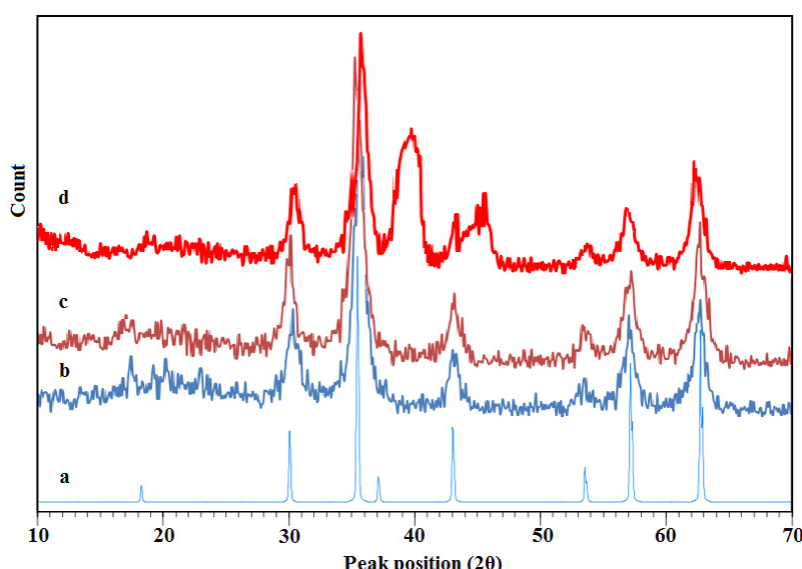
Fig. 2: XRD patterns of (a) standard of Fe